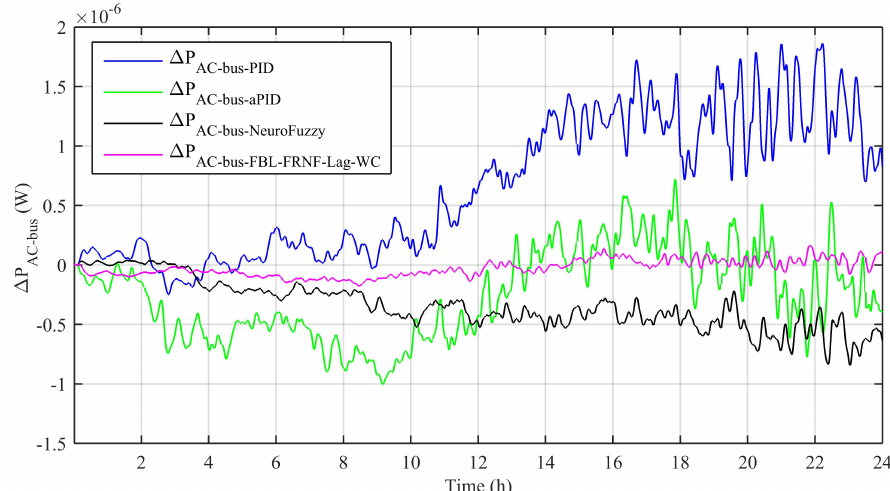
Figure 4. Net real power on the AC bus, ∆ P AC